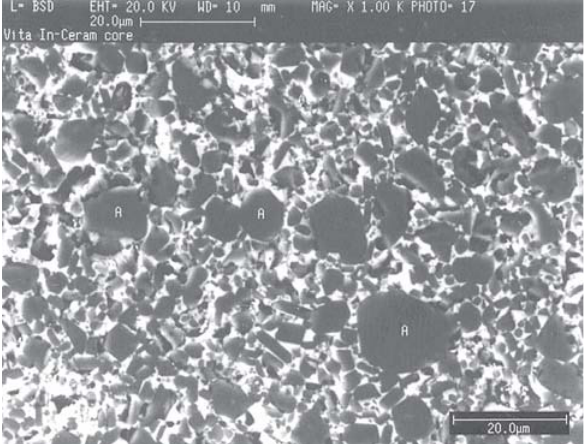
FIGURE 2- Photomicrograph of Fortress (Mirage Dental Systems, Kansas City, KS, USA), a leucite reinforced ceramic. BSI of the microstructure; dark particles (A) are alumina (Al O ). Note that leucite crystals are dispersed in 2 3 the glass matrix and no cracks are found 17